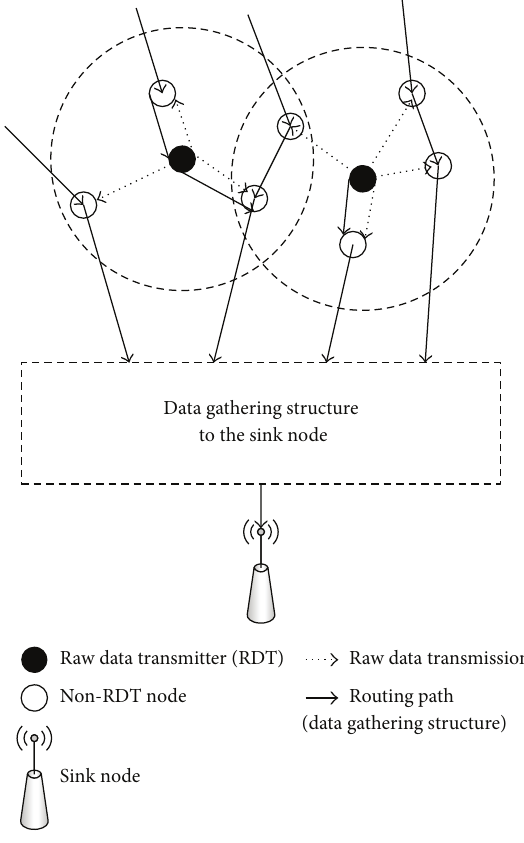
Figure 1: Proposed data compression